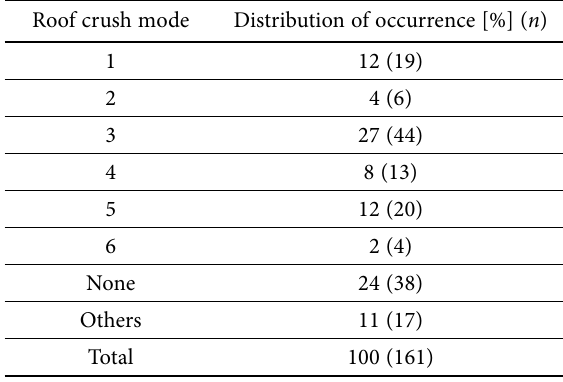
Table 1. Occurrence distributions of roof crush